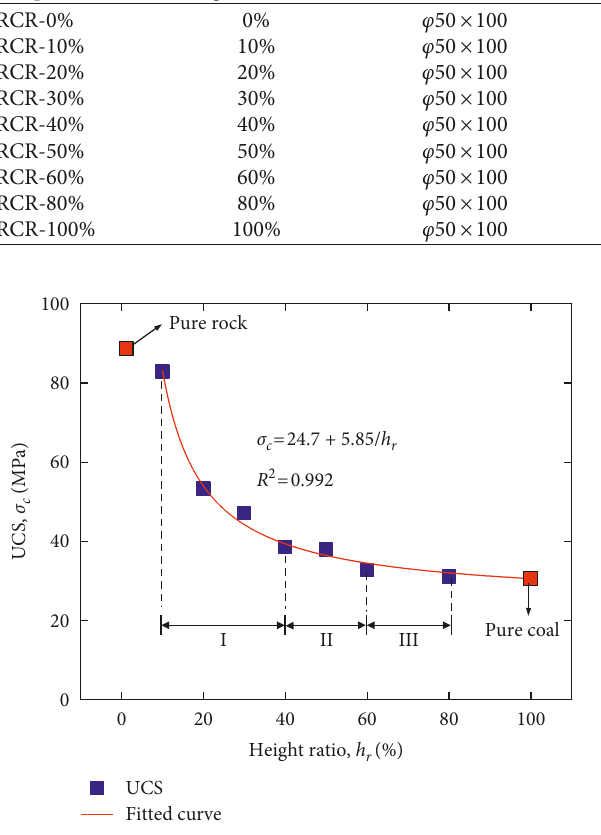
Figure 5: Relation between height ratio and